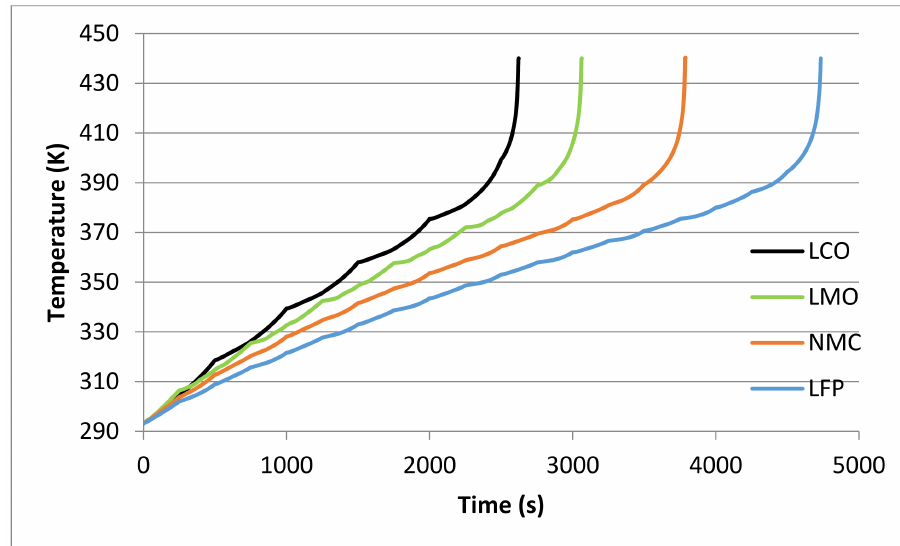
Figure 10. Temperature profiles as a function of time (h = 4 W/m 2 K).